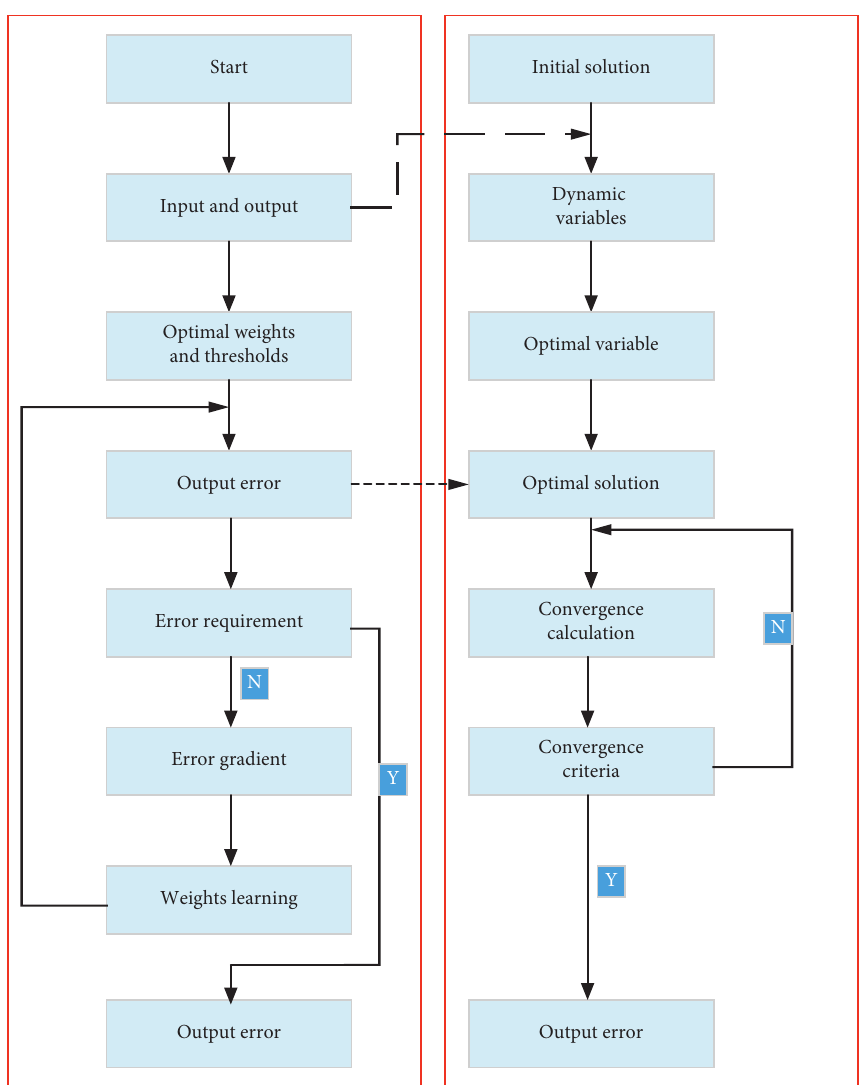
Figure 8: Comparative analysis